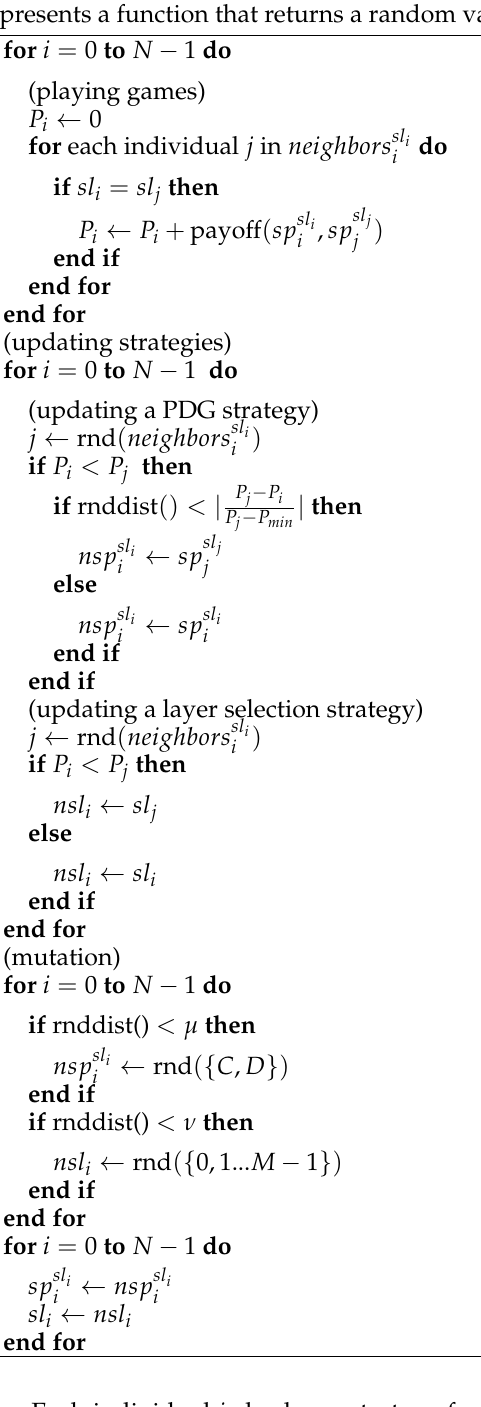
Algorithm 1 A pseudo-code of interaction and evolution processes in a generation. payoff ( a , b ) represents the payoff value obtained by an individual who plays a strategy a with an opponent playing a strategy b . neighbors l represents the set of the neighbors of the individual i in the layer l . i rnd ( s ) represents a function that returns a randomly selected element from the set s . rnddist () also represents a function that returns a random value from the uniform distribution [0,